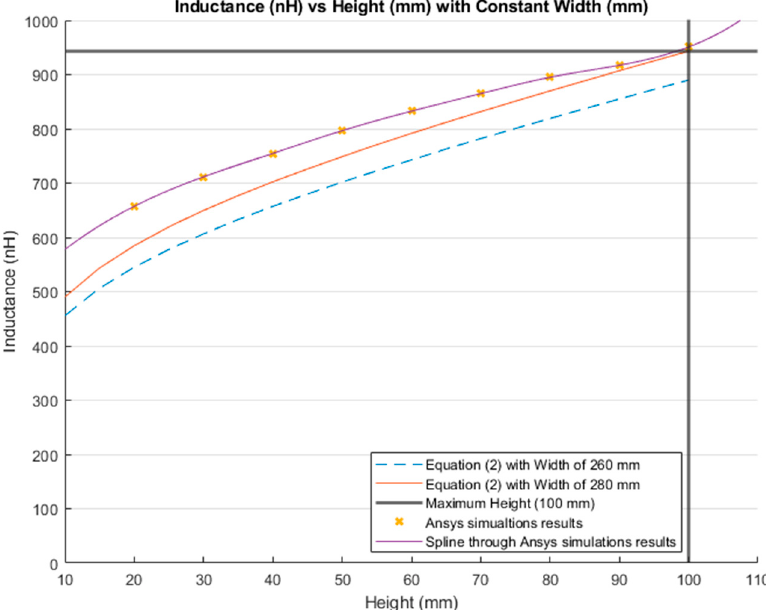
Figure 19. Comparison between the theoretical inductance calculations using Equation (2) and simulation results using a constant width (mm).